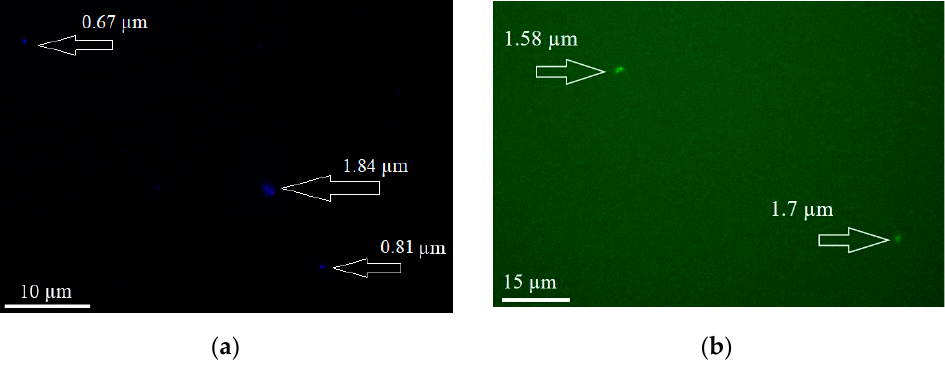
Figure 5. Fluorescent labeling of vesicular SNAs with ( a ) laurdan and ( b )